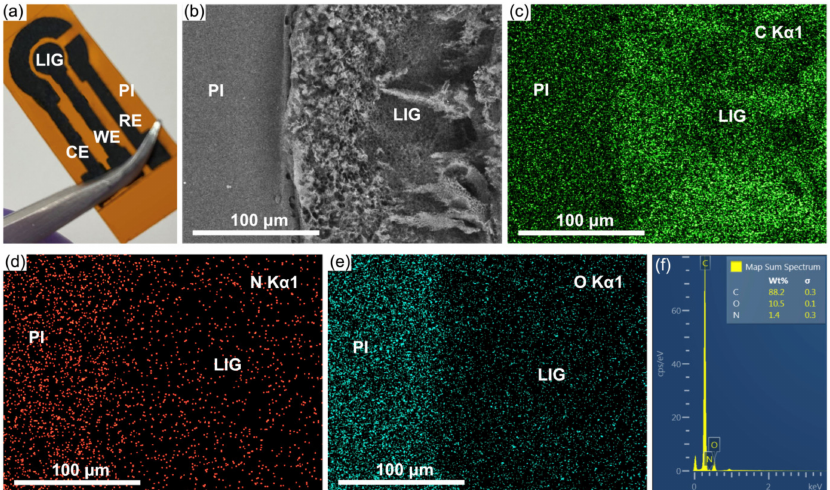
Figure 2. ( a ) LIG-based three-electrode system; ( b ) SEM-EDS micrography; ( c ) EDS mapping